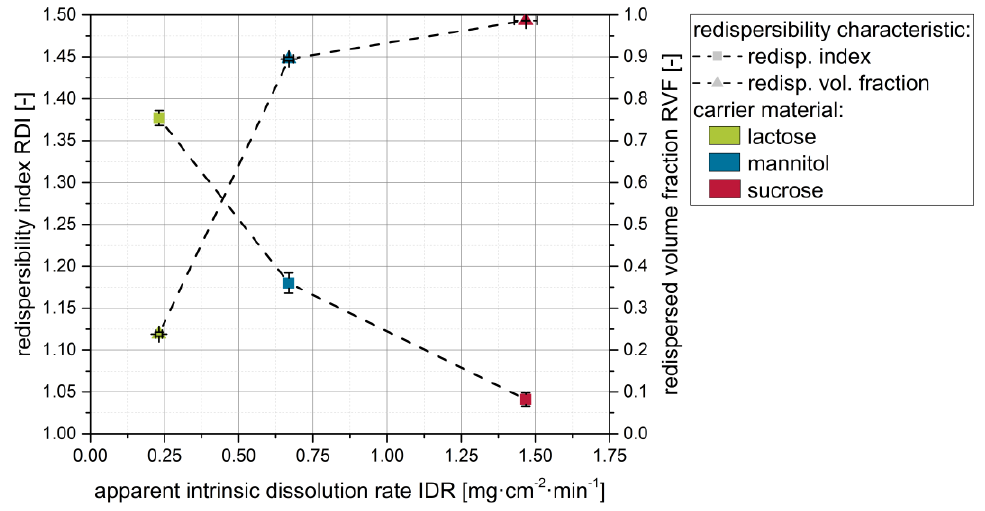
Figure 5. Effect of the apparent intrinsic dissolution rate (IDR) of the carrier material on the redispersibility (i.e., RDI and RVF) of granules produced with a naproxen nanosuspension (stabilized with PVP/VA) without additional drying excipient and different carrier materials (lactose, mannitol, sucrose).